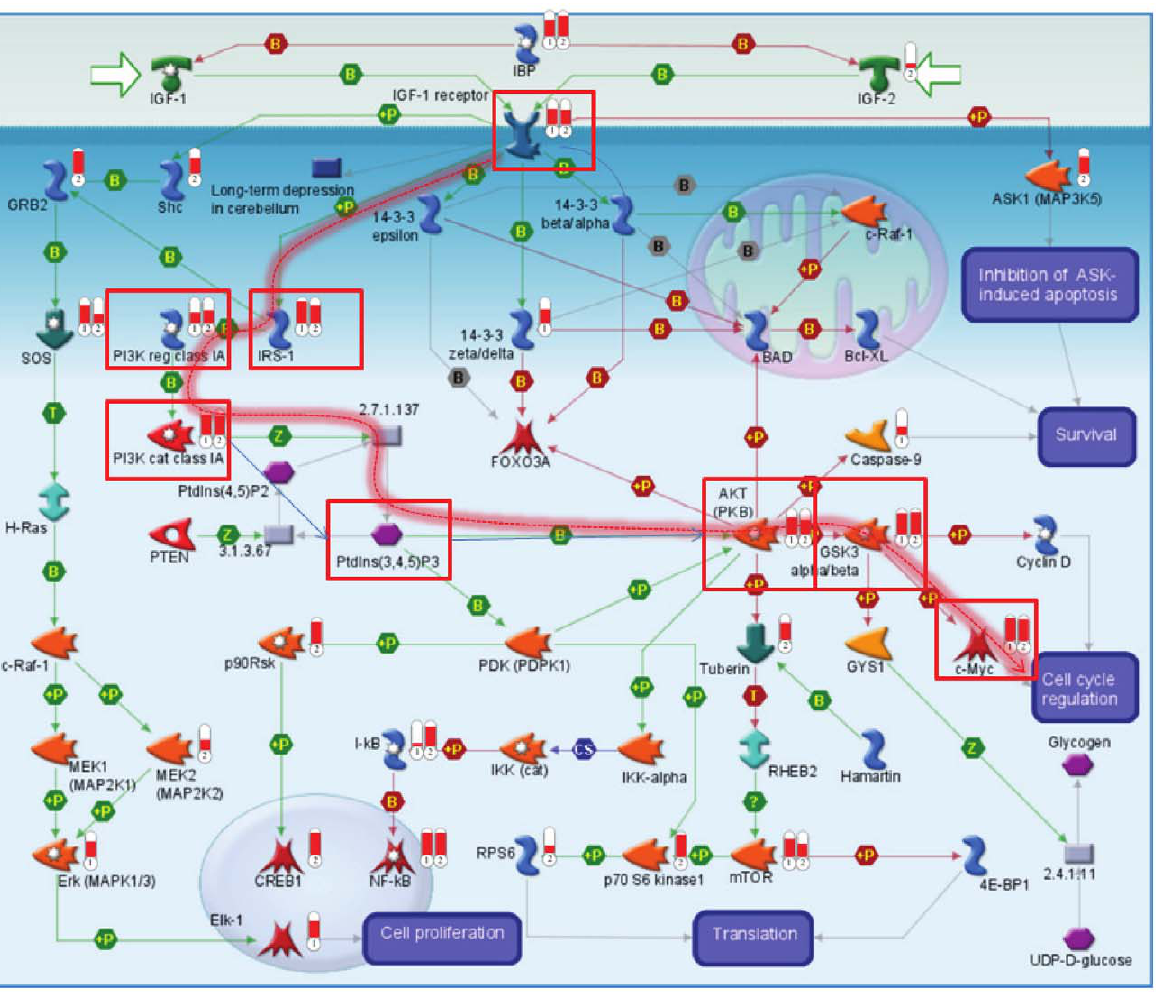
Figure 3. Map for IGF signaling showing topologically significant genes identified from using ‘‘truncated’’ sets of Affymetrix and iTRAQ data. Red level in the ‘‘thermometers’’ represents relative rank (percentile) of a protein in the corresponding list of topologically significant proteins. The number identifies the dataset from which significance was calculated: 1-iTRAQ, 2-Affymetrix. Red boxes and highlighted path illustrate signaling cascade with strongest support from both sets.